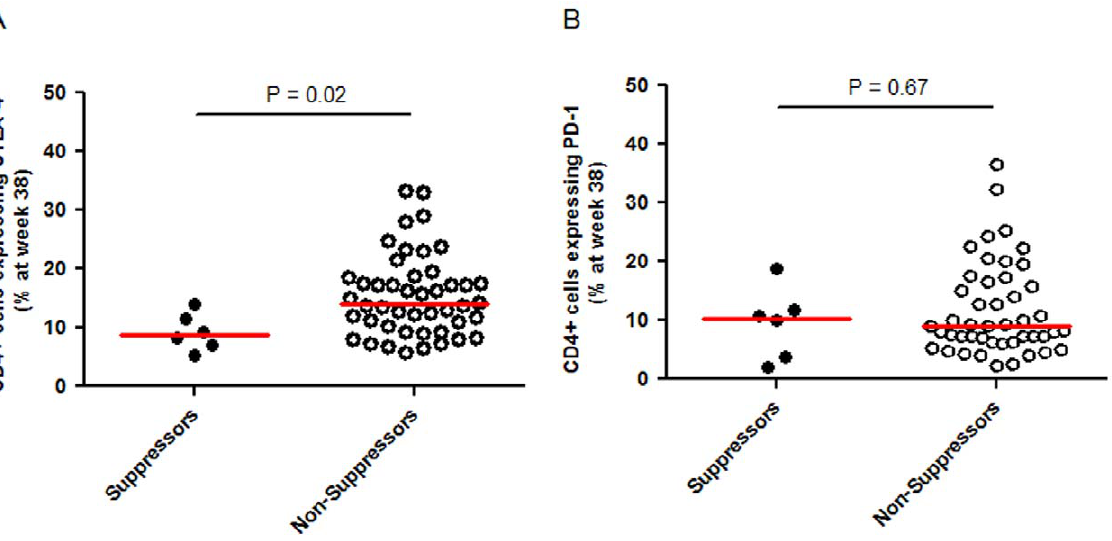
Figure 3. Expression of HIV-1 CD4 + T cells expressing either CTLA-4 + or PD-1 + by participants with and without initial virologic suppression. Panel A, Percentage of CD4 + T cells expressing CTLA-4 at week 38 detected using flow cytometry. Panel B, Percentage of CD4 + T cells expressing PD-1 at week 38 detected using flow cytometry.